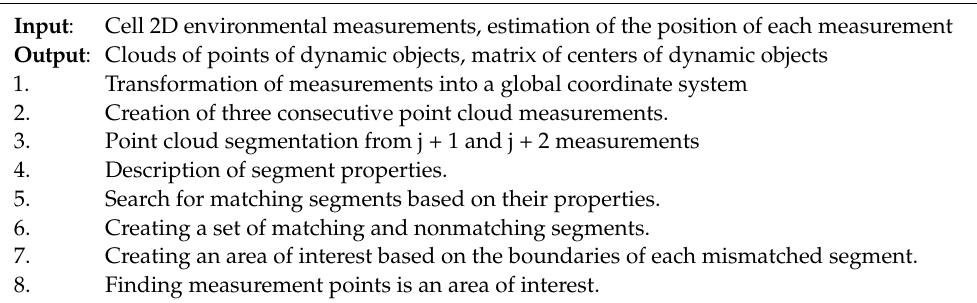
Algorithm 1 Dynamic Object